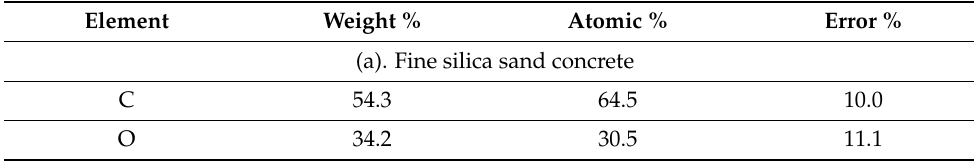
Table 3. Element composition in concrete